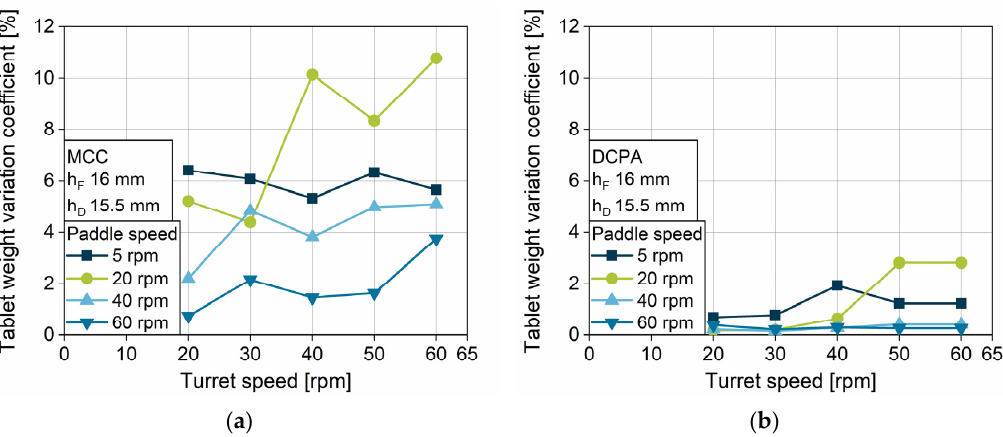
Figure 8. Effect of turret speed on the tablet weight variation for ( a ) MCC and ( b ) DCPA at different paddle speeds.